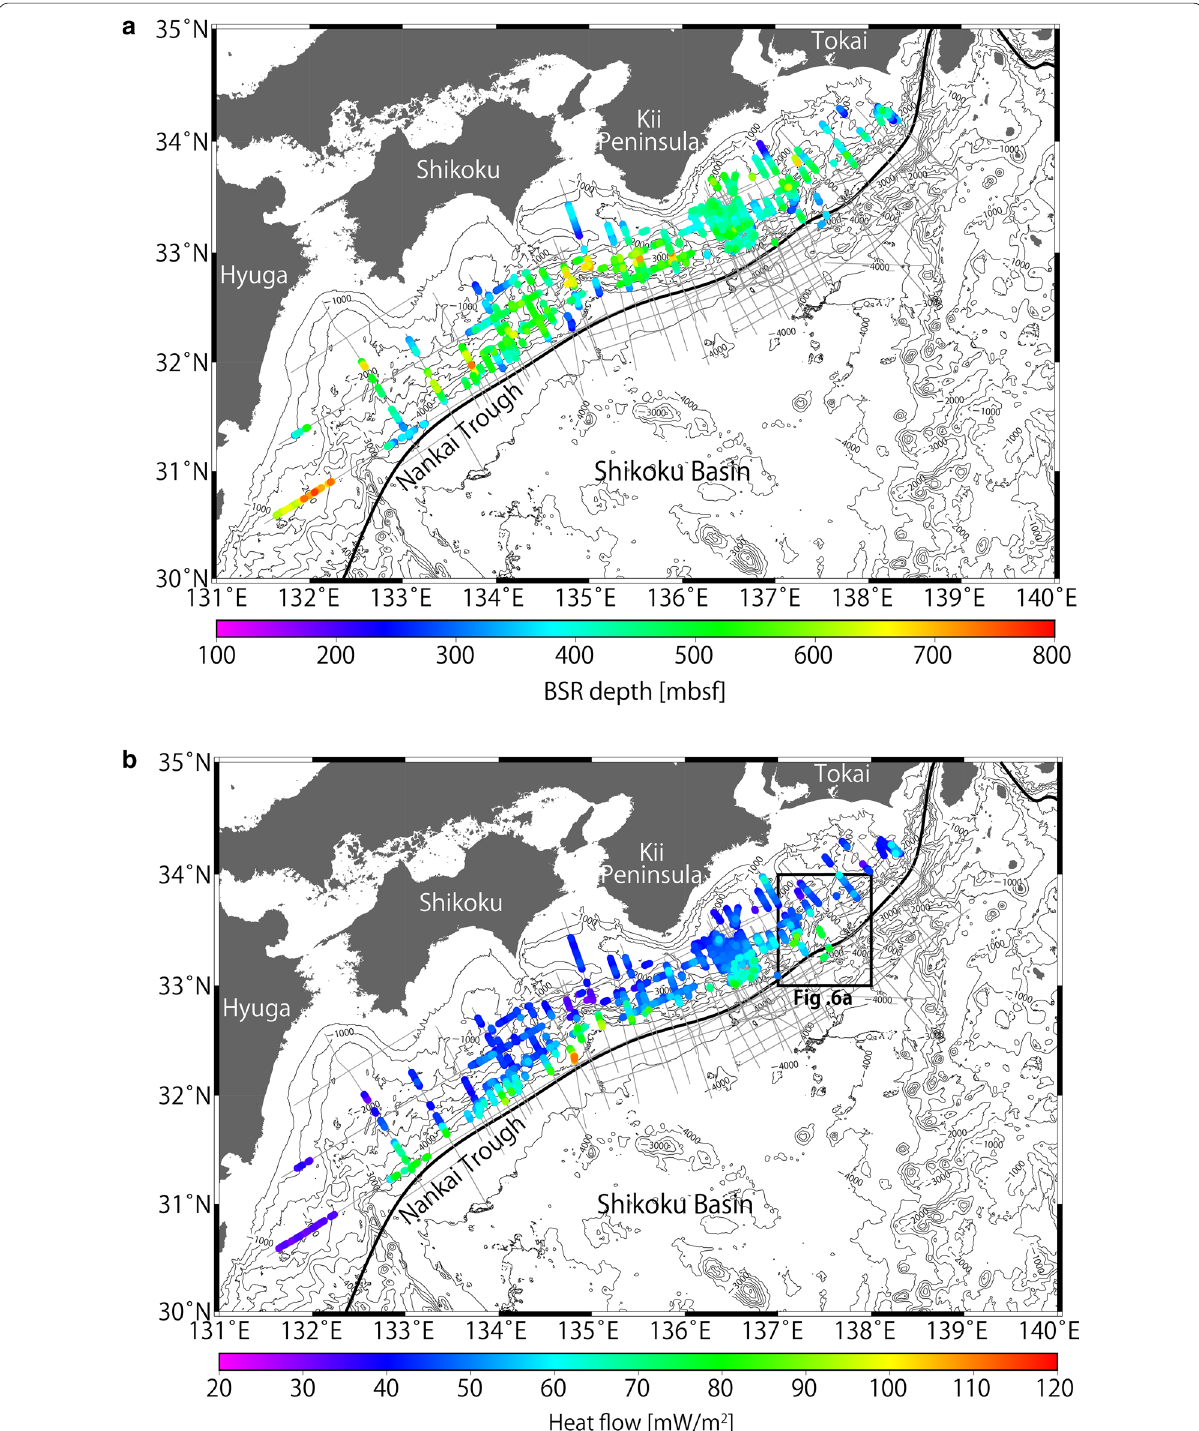
Fig. 3 Distributions of methane hydrate BSRs in the Nankai subduction zone. a Colored dots indicate BSR depths below the seafloor. Survey lines are represented by gray lines. b Colored dots indicate the topographically corrected and uncorrected heat flow derived from the BSRs in this study. Locations of topographically corrected sections are denoted in Fig. 1. Studied MCS profiles are represented by gray